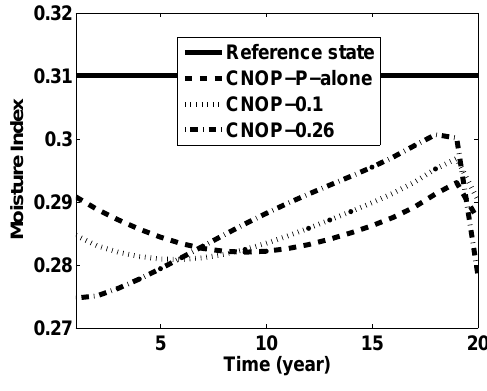
Fig. 2. Fig. 2. Same as in Fig. 1, but for δ 2 = 0 .